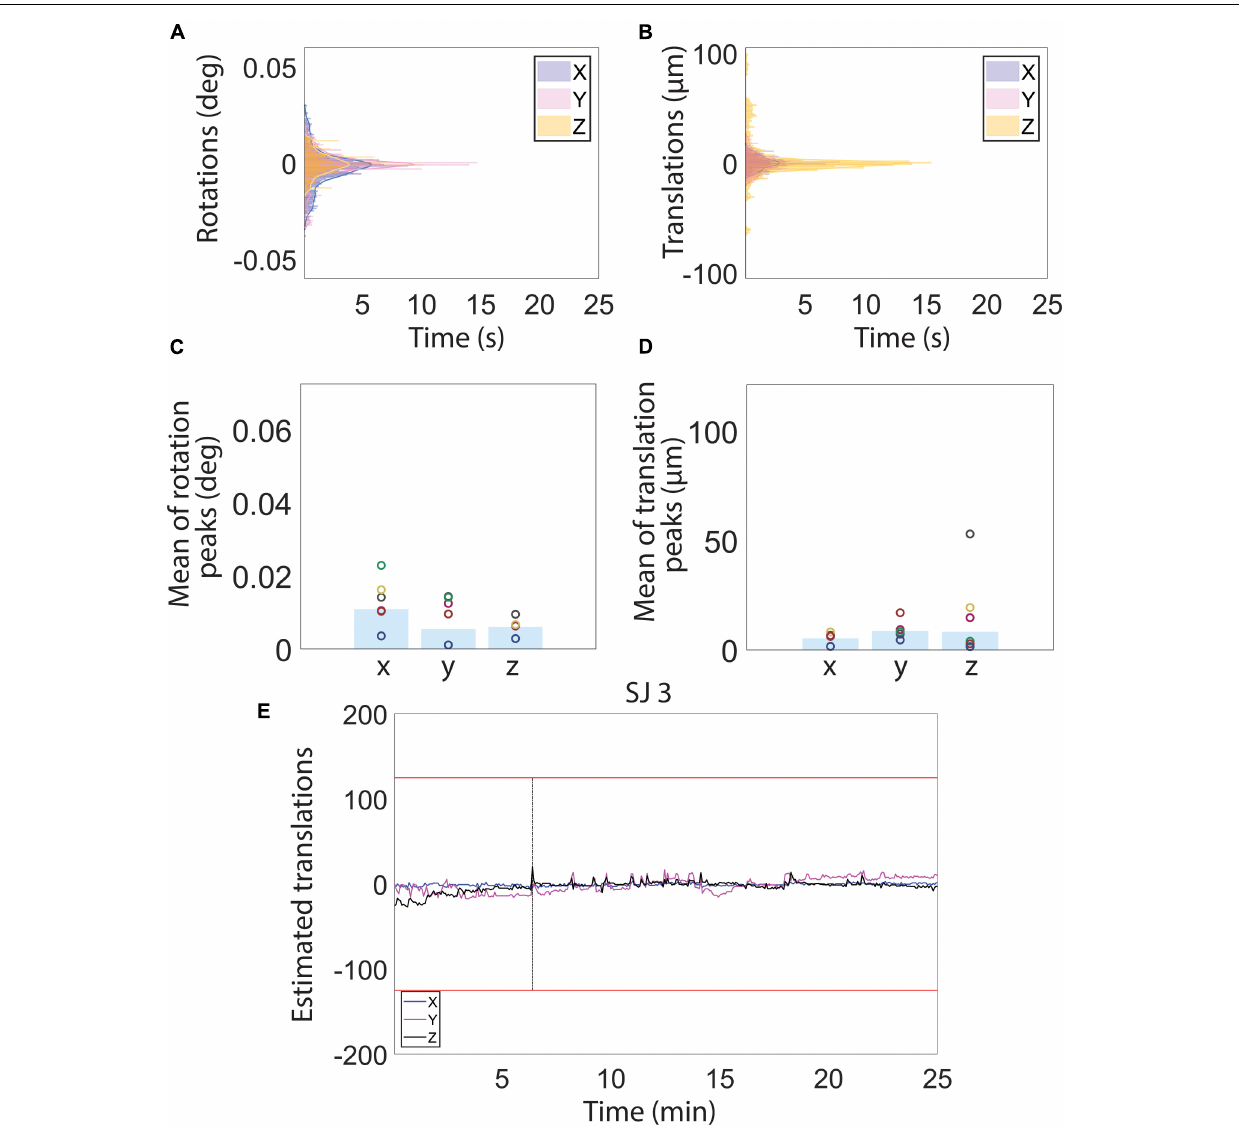
FIGURE 5 | Motion estimations derived from MR images during the auditory functional magnetic resonance imaging (fMRI) acquisition. (A–D) Histograms (A,B) and peak mean of the estimated rotation (C) and translation (D) motion parameters. (E) Representative example of estimated translation levels for a single subject (SJ 3). (See Figure 6 for motion traces of all other subjects). The red lines represent 1/4 of the voxel size. The vertical black line indicates the location of a spike in the time course that was removed using the Matlab toolbox, ArtRepair. Low estimated motion parameter values recorded during the whole fMRI acquisition reflect a physiological and calm state of the